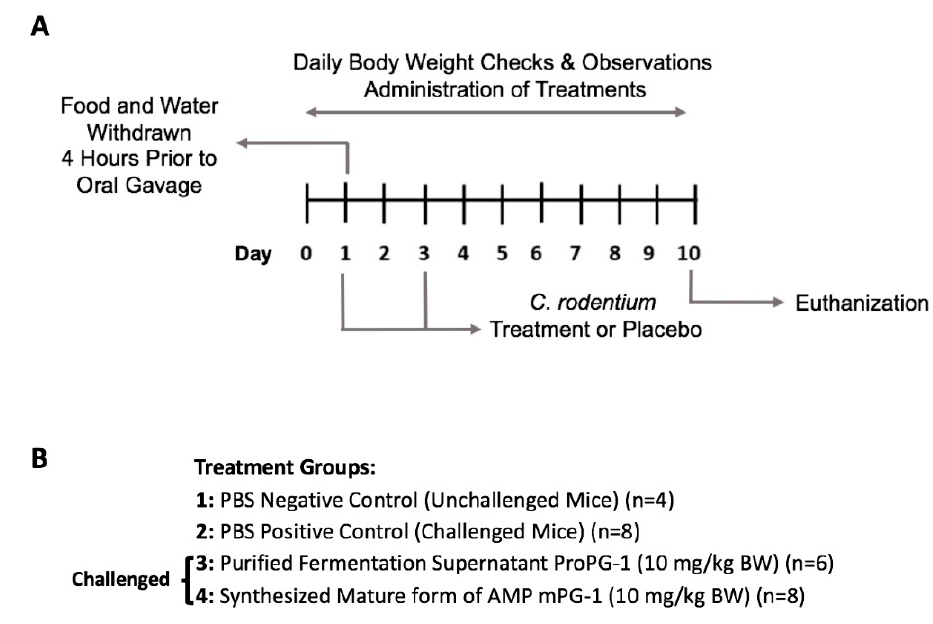
Figure 1. Animal Study Design. ( A ) The trial timeline for induction of colitis. ( B ) Treatment groups. Mice were challenged with C. rodentium (2 × 10 9 CFU/mL) or left unchallenged (PBS) and were treated daily with ProPG-1, mPG-1, or PBS. Two mice within the ProPG-1 group died due to gavage complications; six mice in this group completed the study.